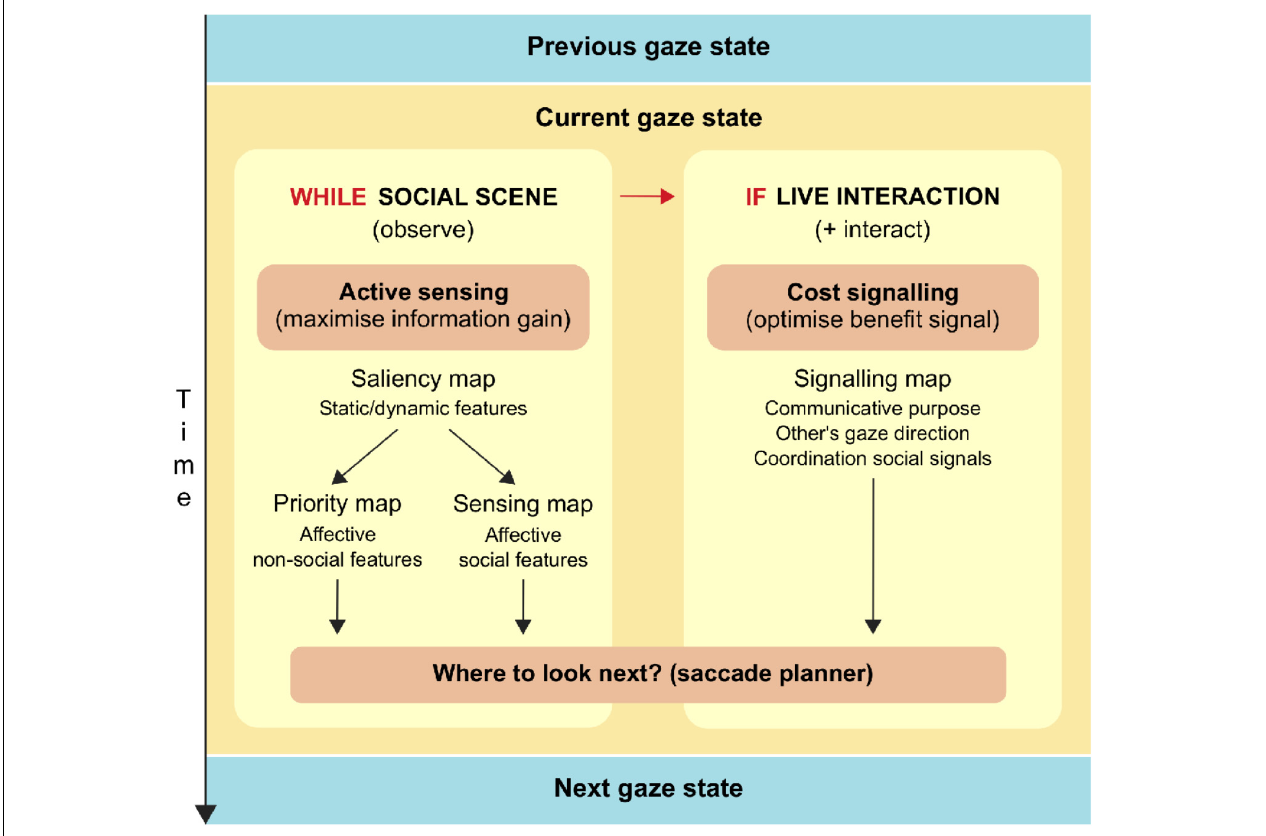
FIGURE 2 | Diagram summarizing the Interpersonal Gaze Processing